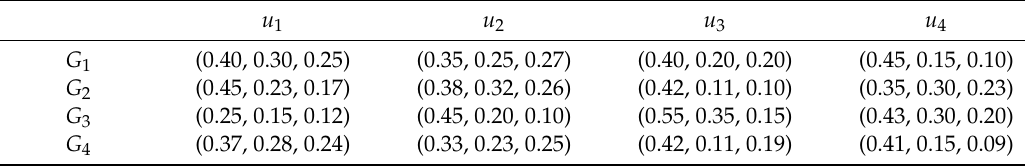
Table 2. Normalized petroleum circulation center